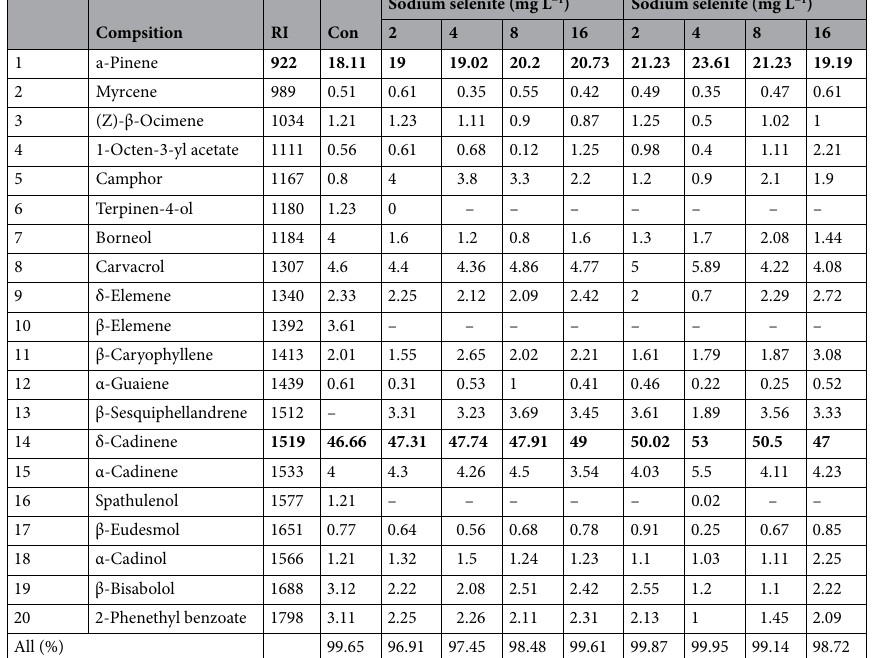
Table 2. The effect of selenium sources and flowering stages on some essential oils of Echium amoenum. Significant values are in